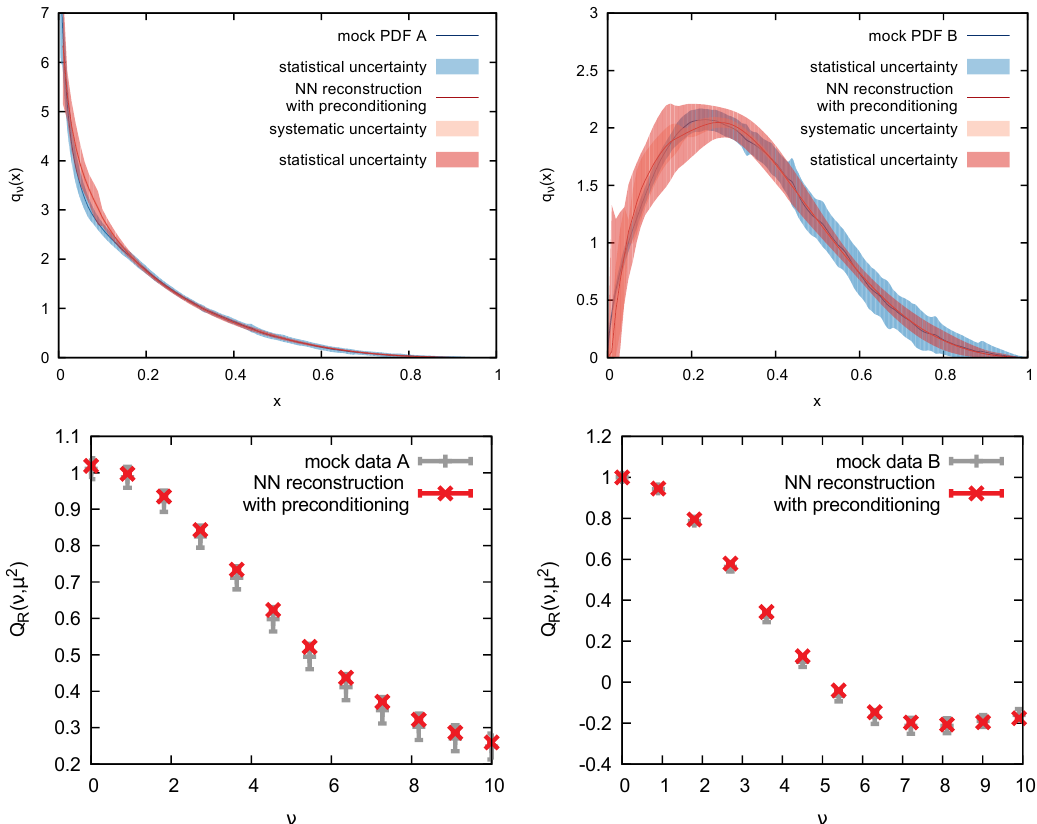
Figure 11 . The PDF reconstructions from preconditioned Neural Networks (top). The grey points are the original data while the red points are the ones reconstructed by the NN (bottom). The left is scenario A and the right is scenario